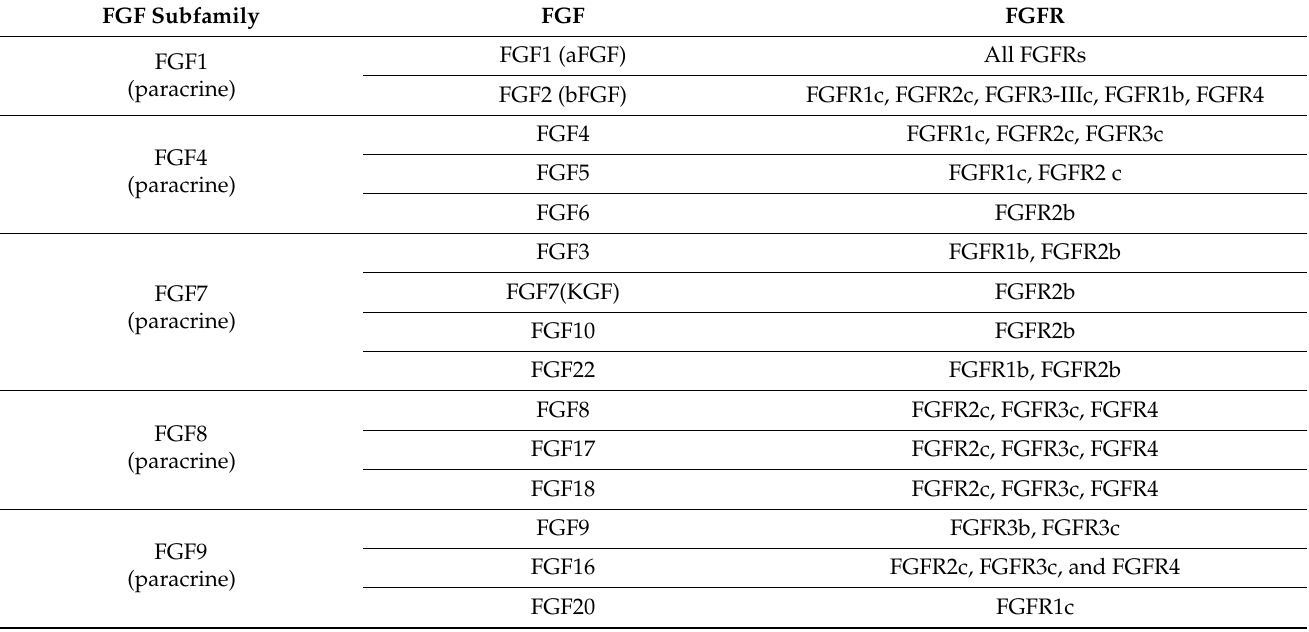
Table 1. The classification of FGF ligands and their corresponding